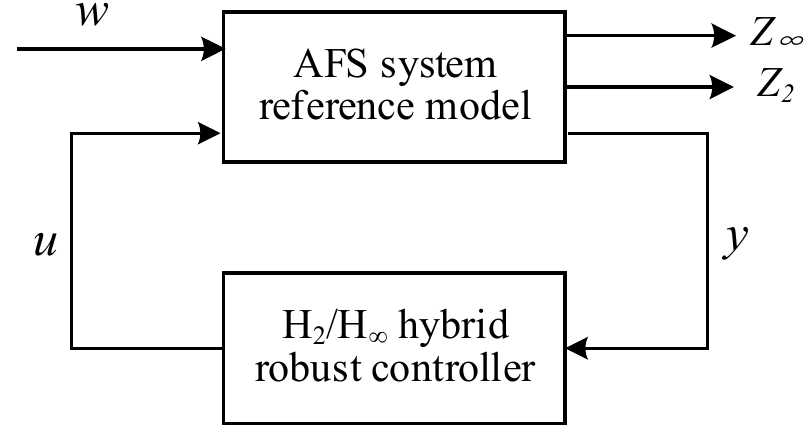
Figure 5. Principle of H 2 /H ∞ hybrid robust